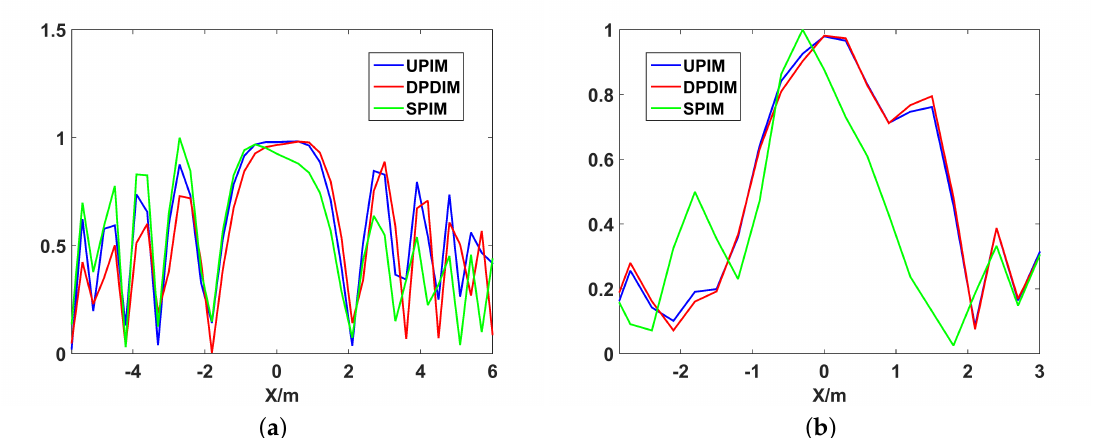
Figure 8. The profile of the point spread function of UPIM, DPIM, and SPIM. ( a ) the X -axis profile of the point spread function; ( b ) the Y -axis profile of the point spread function.